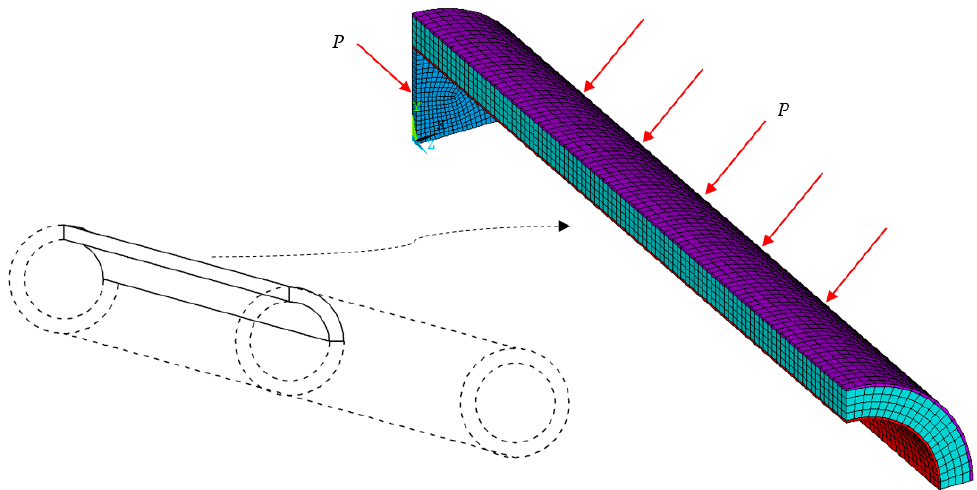
Figure 2. Mesh division and loading condition of numerical calculation case.